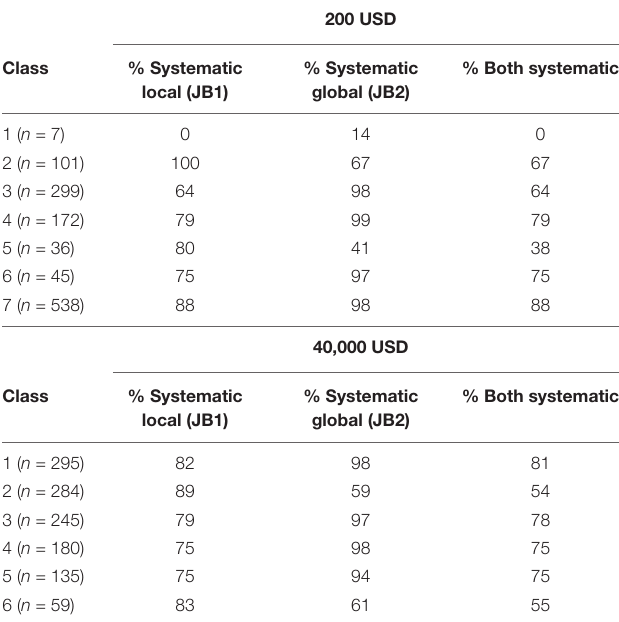
TABLE 3 | Latent class linear mixed modeling across discounting tasks.